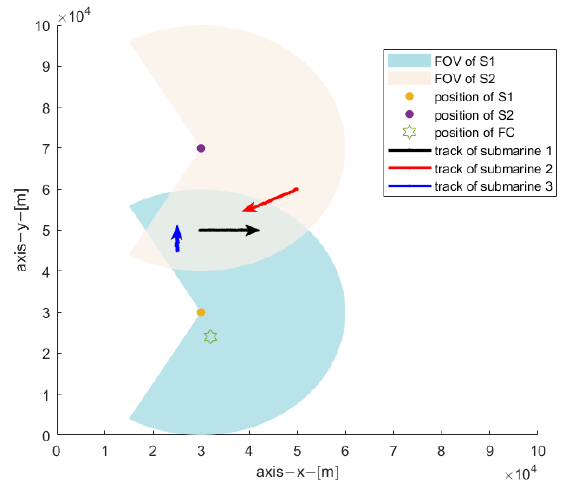
Figure 4. Simulation scenario, with FC denotes the fusion center.